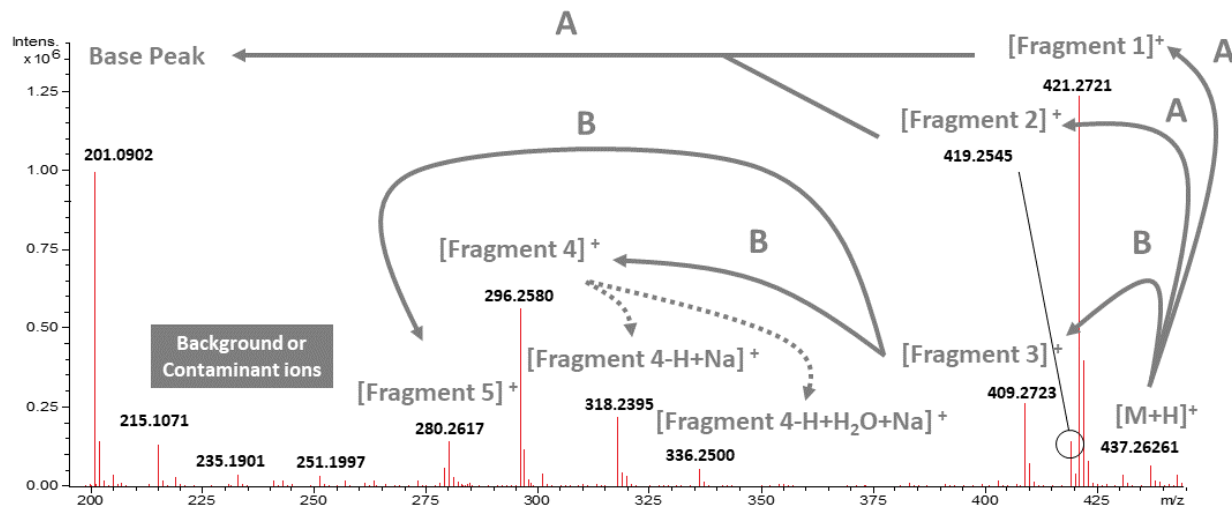
Figure 1. Observed ESI-MS spectrum of the obtained 20-HM and its proposed mass fragmentation. A and B indicate the mass fragmentation presenting in routes A and B from Figure 2 (below).